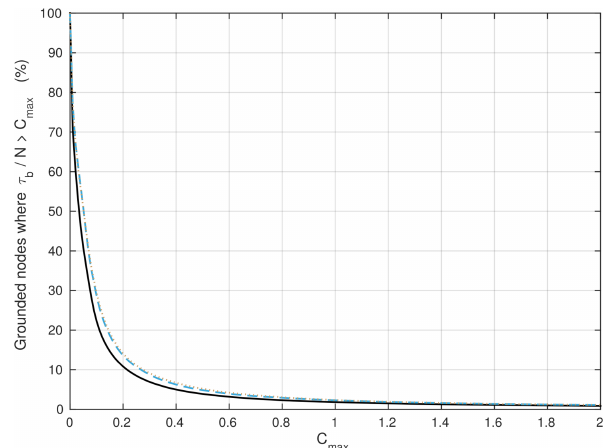
Figure 3. Percentage of grounded nodes where Iken’s bound is not satisfied as a function of the value attributed to the parameter C max for the inferred states I R (black solid line), I Rγ, 100 (blue dashed γ, ∞ line) and I Rγ, 1 (brown dotted